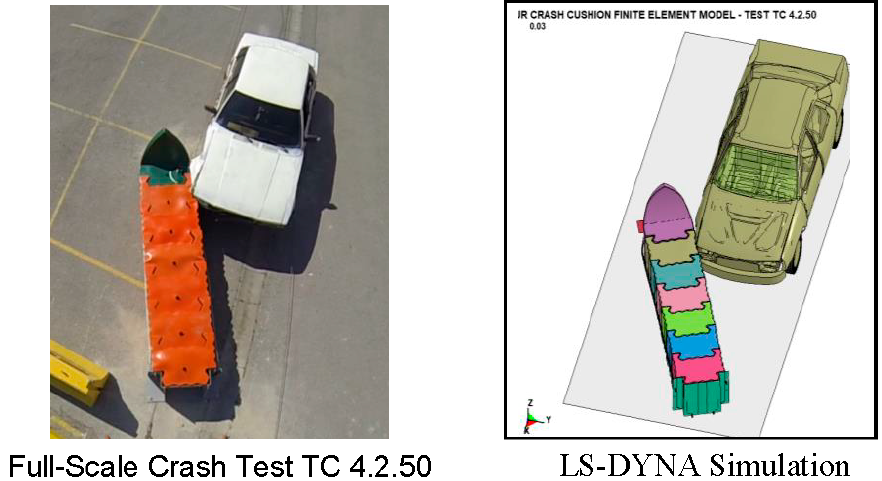
Figure 9. The 1300 kg car positioned in front of UCC barrier before TC 4.2.50.